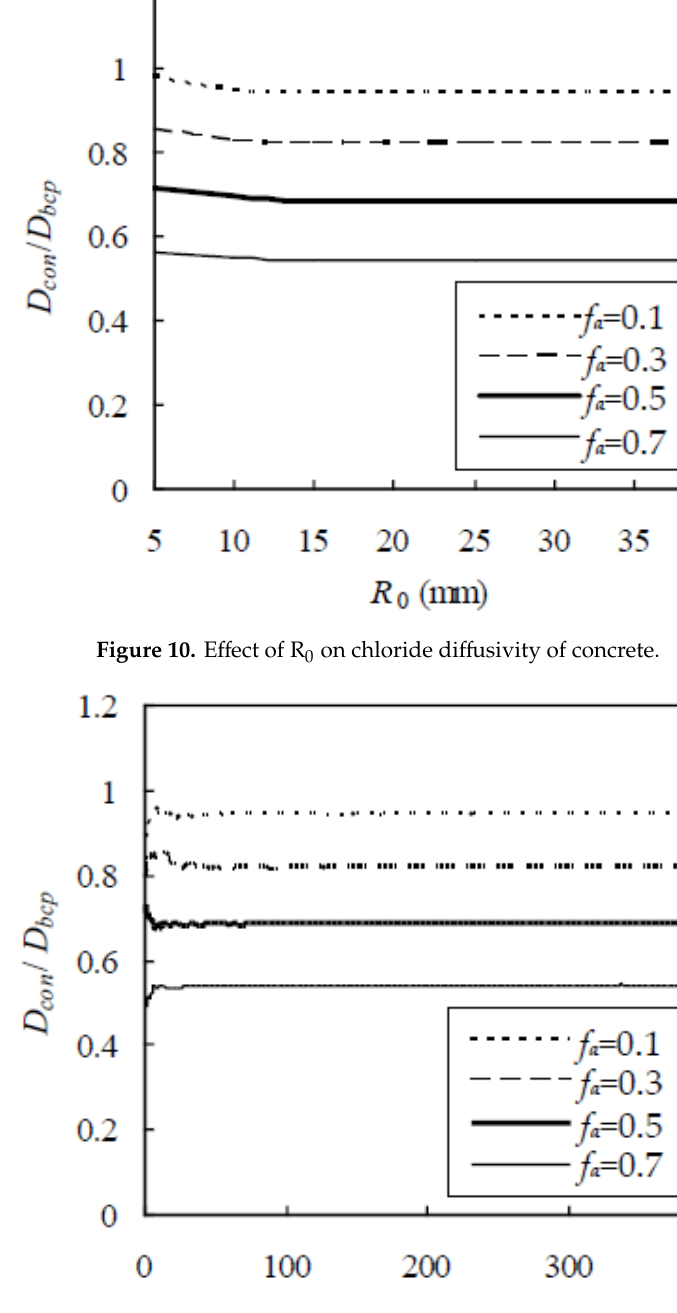
( d ) Figure 9. Random walk paths for ( a ) R 0 = 20 mm; ( b ) R 0 = 30 mm; ( c ) R 0 = 40 mm; and ( d ) R 0 = 60 mm.